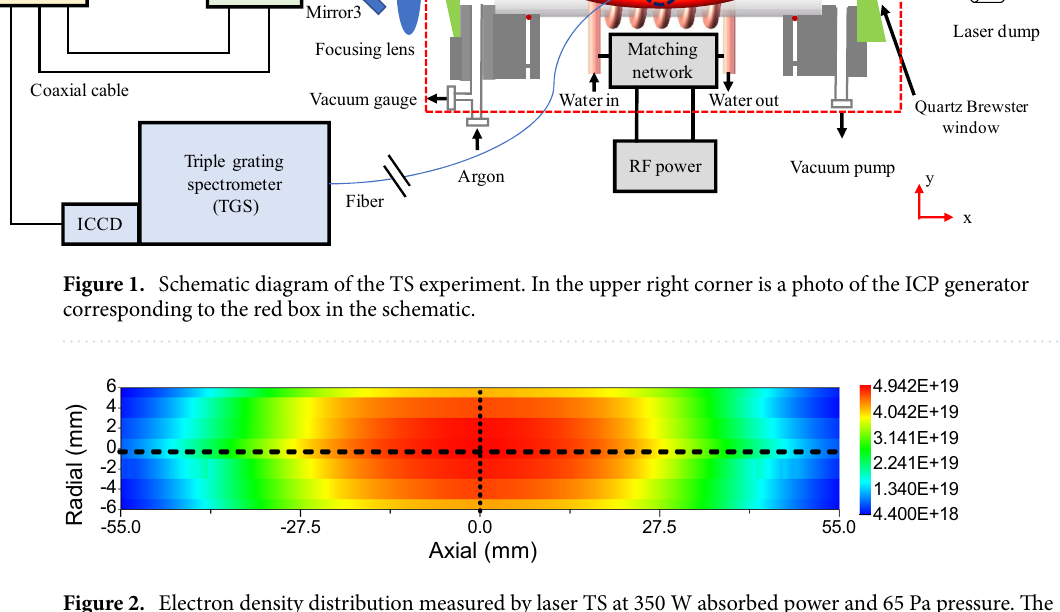
Figure 2. Electron density distribution measured by laser TS at 350 W absorbed power and 65 Pa pressure. The dotted line and dashed line in the figure indicate the locations of the cut line data to be